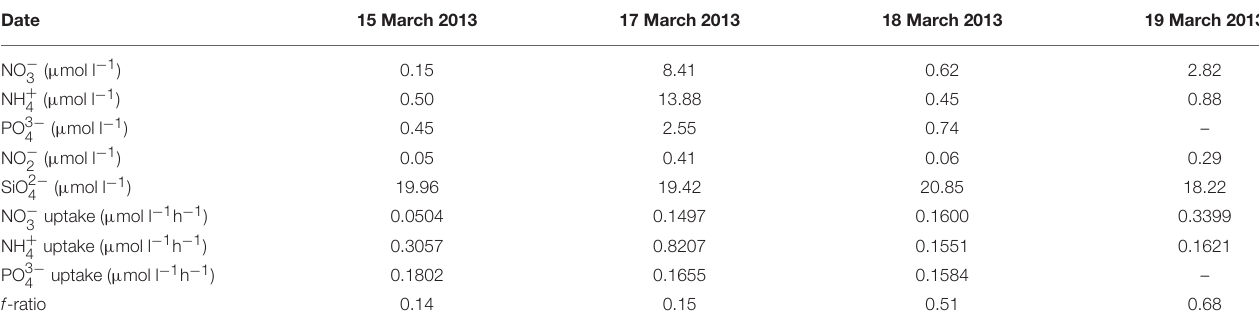
TABLE 2 | Date of surface water collection, NO − 3 , NH + 4 , PO 3 − 4 , NO − 2 , and SiO 2 − 4 concentrations, the rates of uptake of NO − 3 , NH + 4 , and PO 3 − 4 , and the f -ratio.